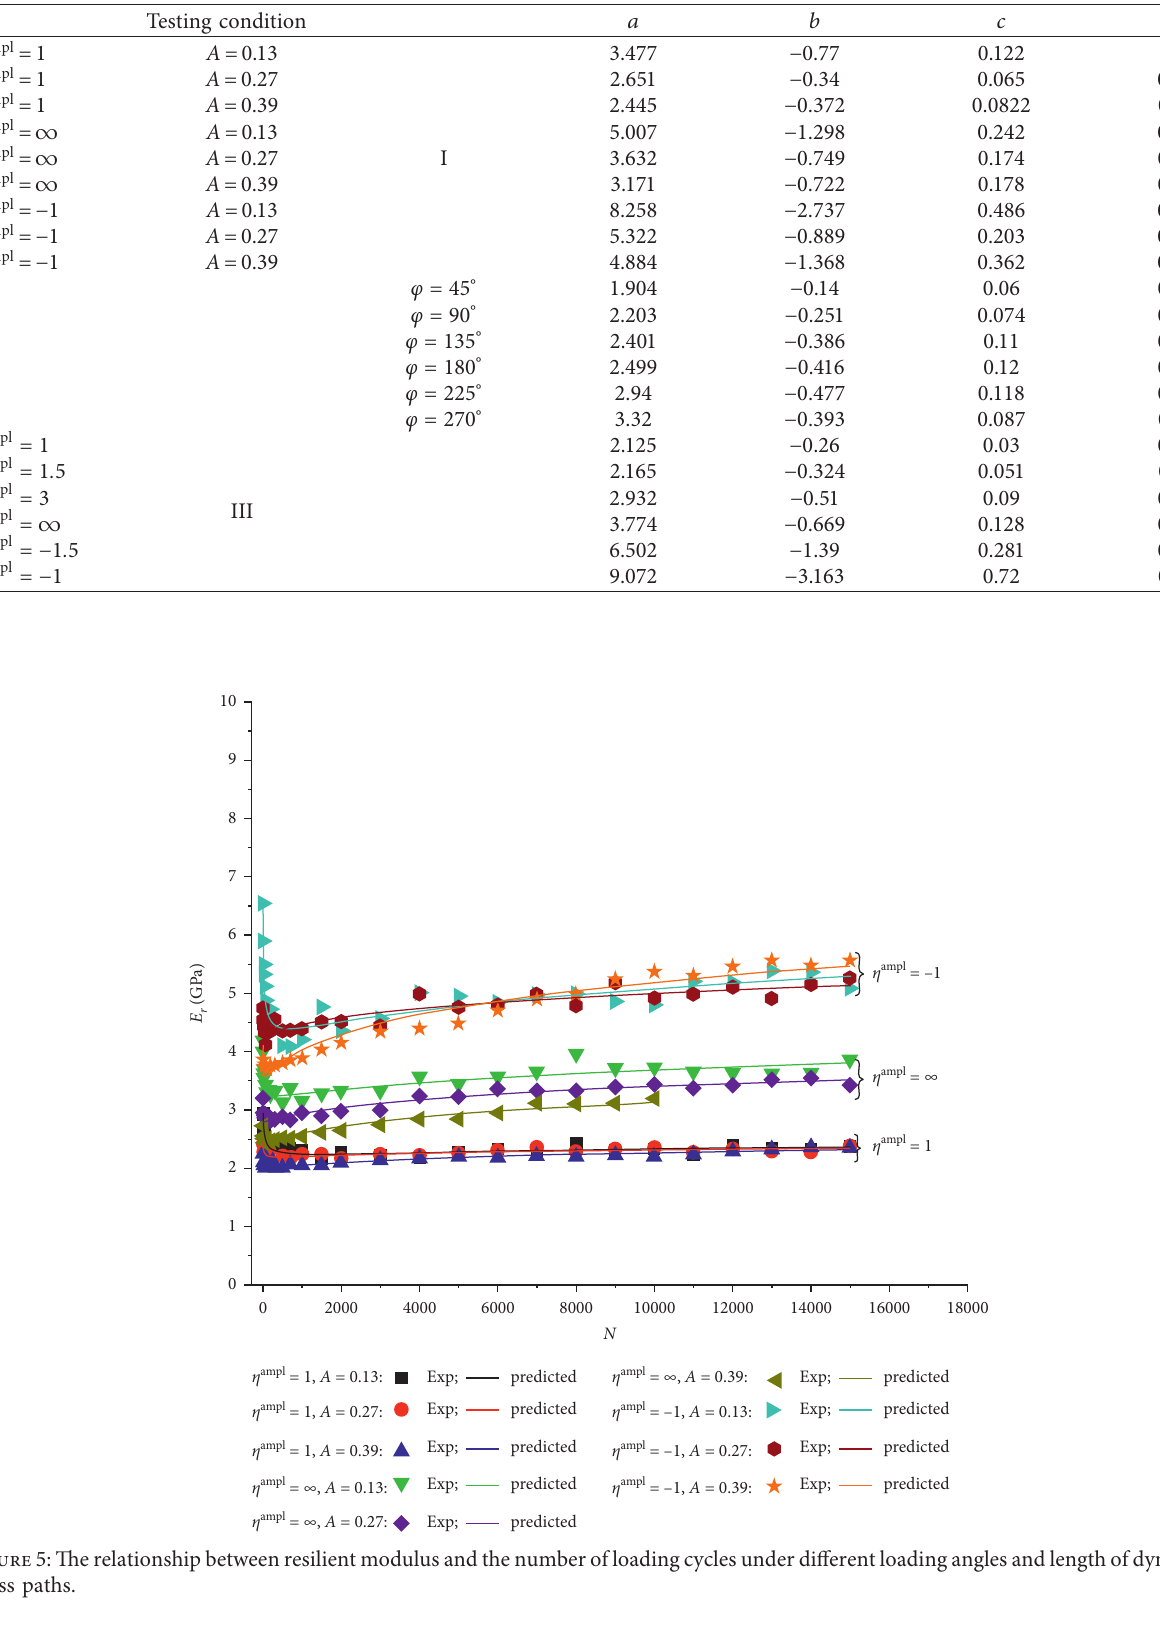
Table 4: Fitting parameters and R 2 of resilient modulus under various dynamic stress paths.